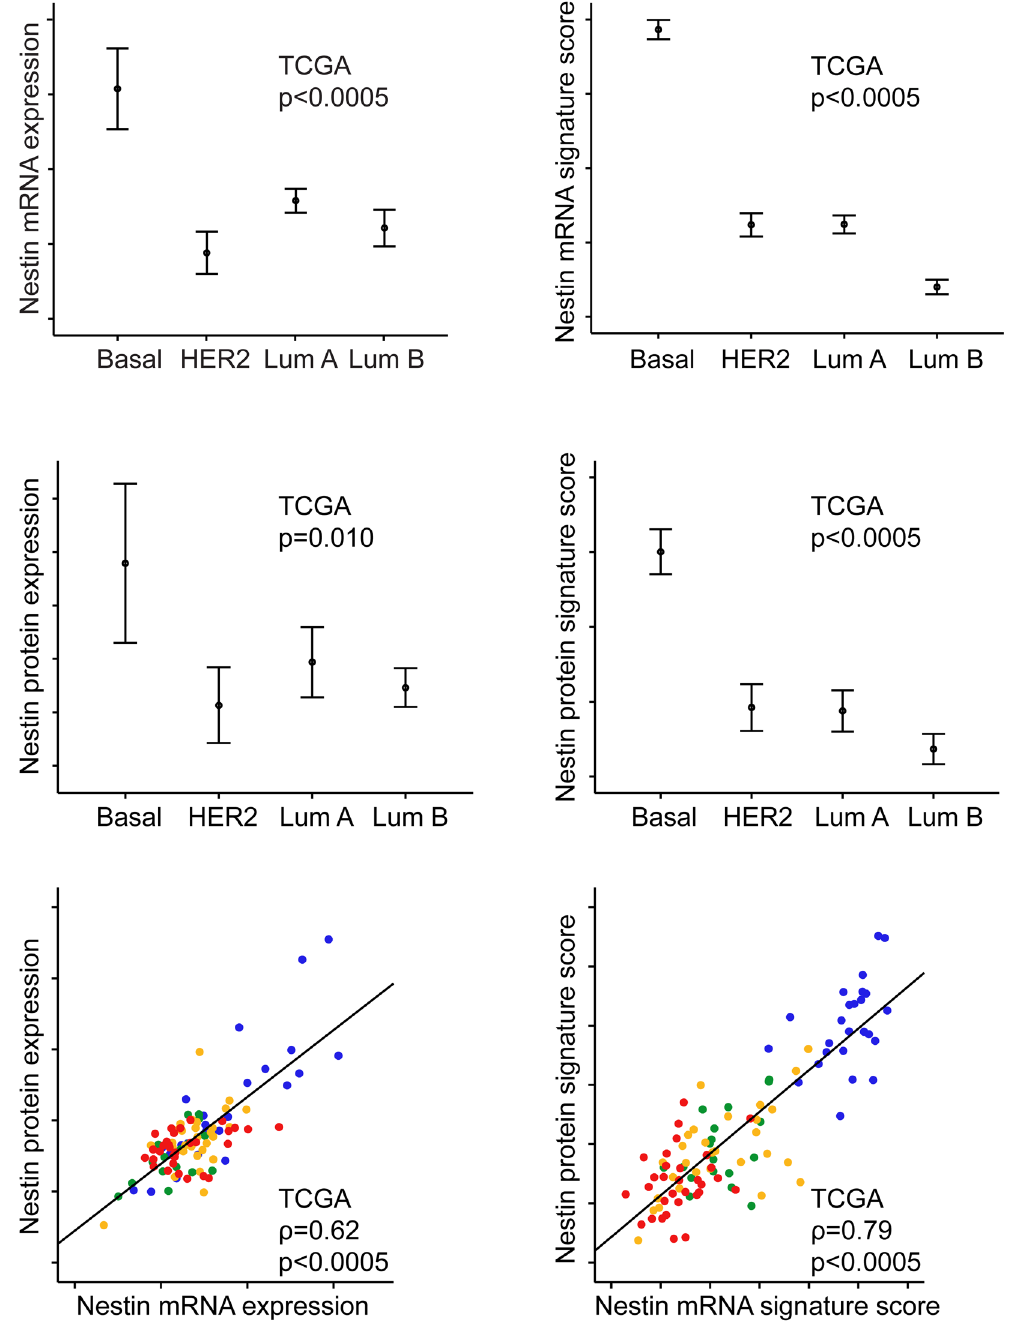
Figure 2. Nestin mRNA, protein expression and signature scores across molecular subtypes of breast cancer in the TCGA dataset, and correlation of Nestin mRNA, protein expression and signature scores. TCGA microarray data (n = 505) of Nestin mRNA ( NES ) expression, Nestin mRNA signature score (44 genes), proteomic data (n = 103) of Nestin protein expression and Nestin protein signature score (27 of 44 proteins) across molecular subtypes of breast cancer. Data is presented by error-bars with 95% confidence interval of the mean, and p-values by the Kruskal-Wallis test. Scatter plots for Nestin mRNA and protein expression and mRNA and protein signature score with p-values by Spearman’s rank correlation and the coefficients ( ρ ) are presented. The normal breast-like category was excluded. Molecular subtypes are indicated with colours; basal-like: blue; HER2 enriched: green; luminal A: orange; luminal B;